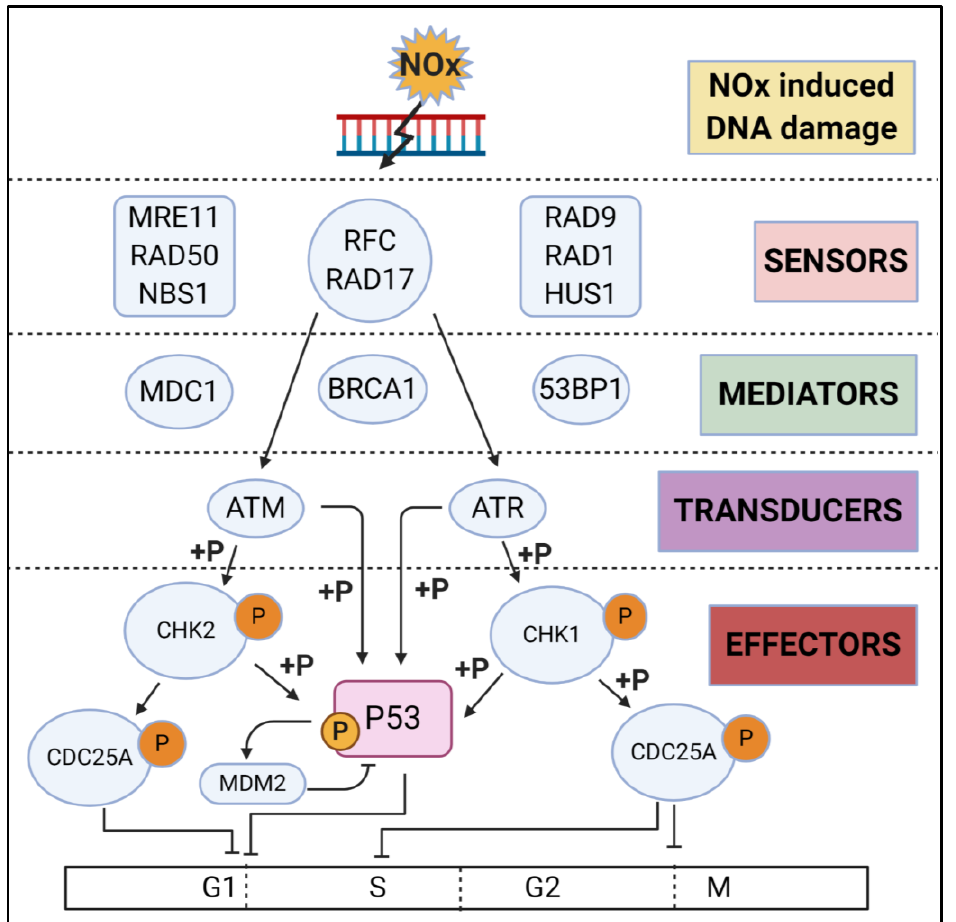
Figure 3. Cell cycle check point responses. RNS-induced DNA damage is sensed by a multitude of DNA damage sensors which relay the signal to the DNA damage transducers ATM and ATR. RNS-induced DNA damage can lead to arrest during different phases of the cell cycle depending on the type of DNA damage and the effector signal activated. Created with BioRender.com.